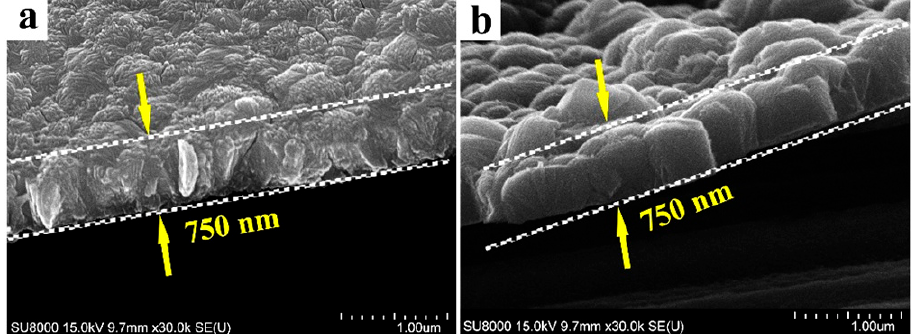
Figure 4. Cross-section morphologies of anatase coatings grown at 170 °C for 12 h in solutions containing: ( a ) 18 mL alcohol, 140 µ L TBOT, 70 µ L HF, 140 µ L NH 4 F (0.1 M); ( b ) 18 mL alcohol, 140 µ L TBOT, 70 µ L HF, 140 µ L NH 4 F (0.2